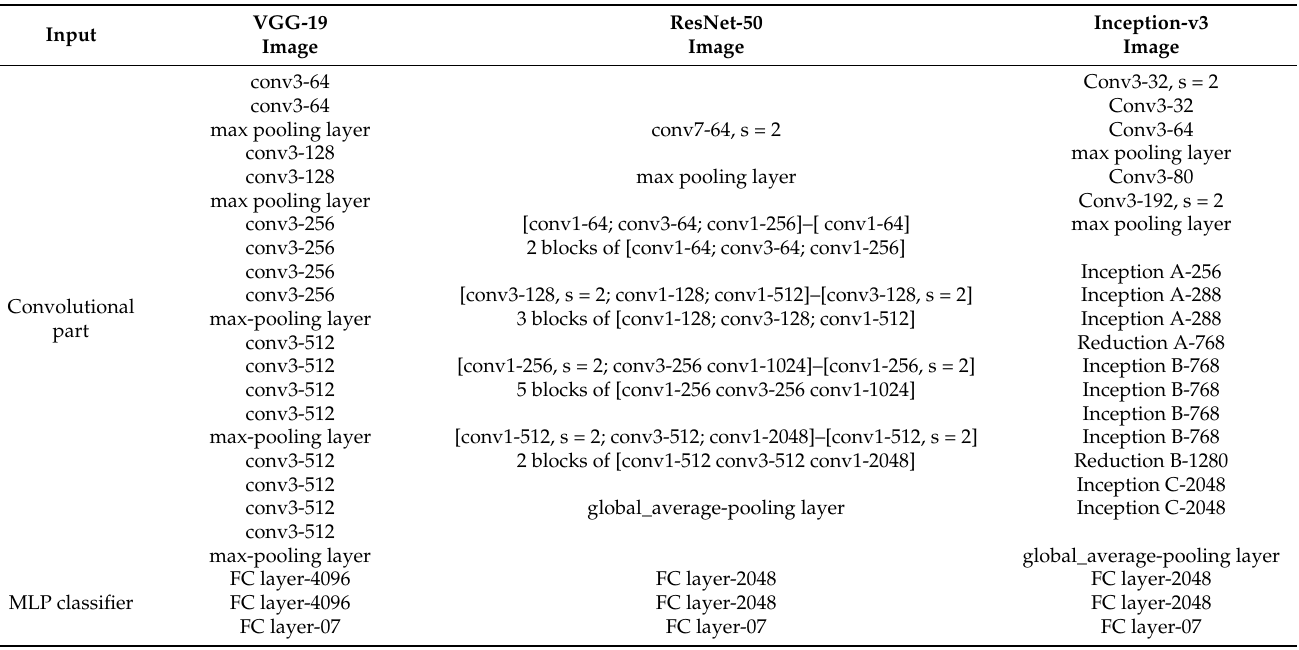
Table 2. Architectures of the three CNN